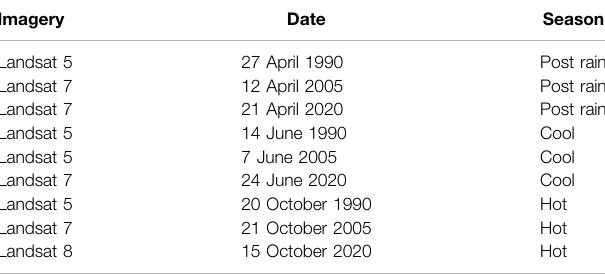
TABLE 2 | Multitemporal and multispectral remote sensing imagery used in the study. Imagery